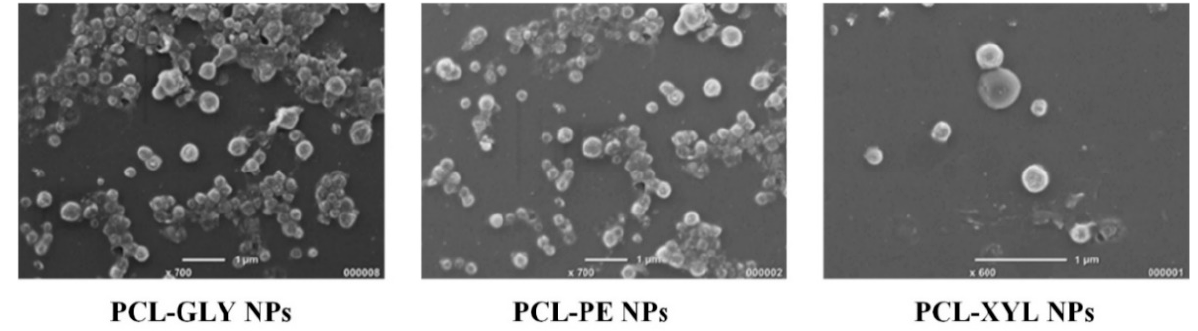
Figure 8. SEM images of PTX-loaded NPs prepared the synthesized PCL-branched copolymers.